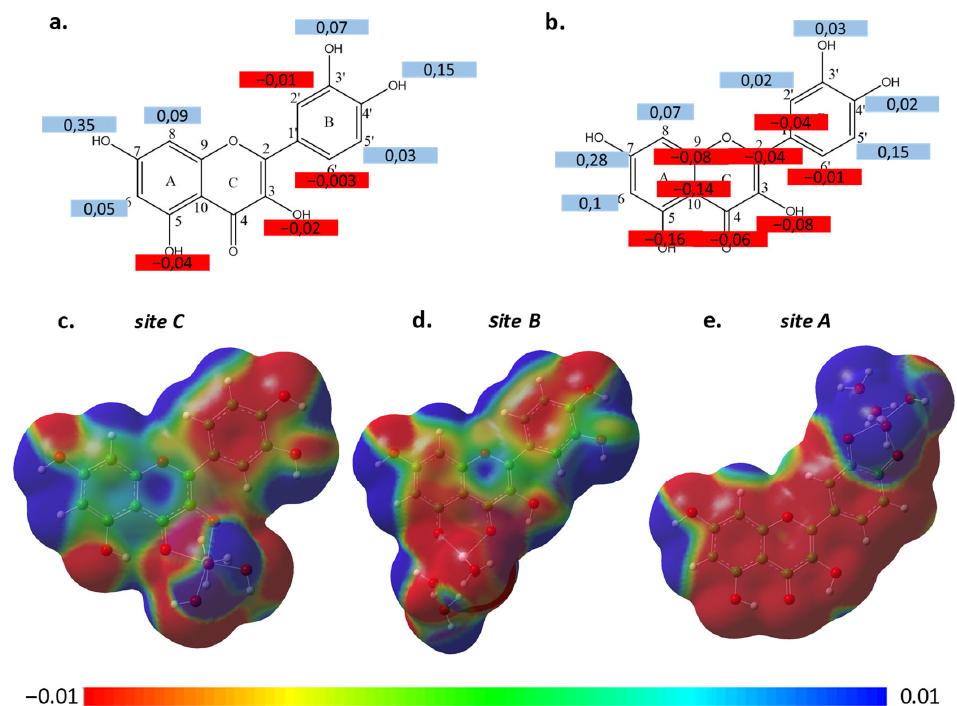
Figure 4. Chemical shift changes maps. ( a ) 1 H-NMR, ( b ) 13 C-NMR. Maps of the molecular electrostatic potential (MEP) of ( c ) site C, ( d ) site B [Al(OH) 2 (Que)] complexes, and ( e ) site A [Al(OH)(Que)] complex. Reproduced from [34], Copyright Elsevier 2021.